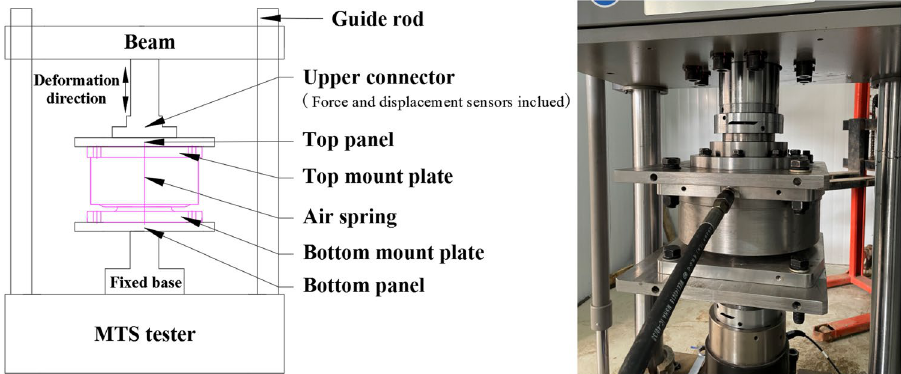
Figure 3. Schematic diagram of the installation structure in the stiffness test of an air